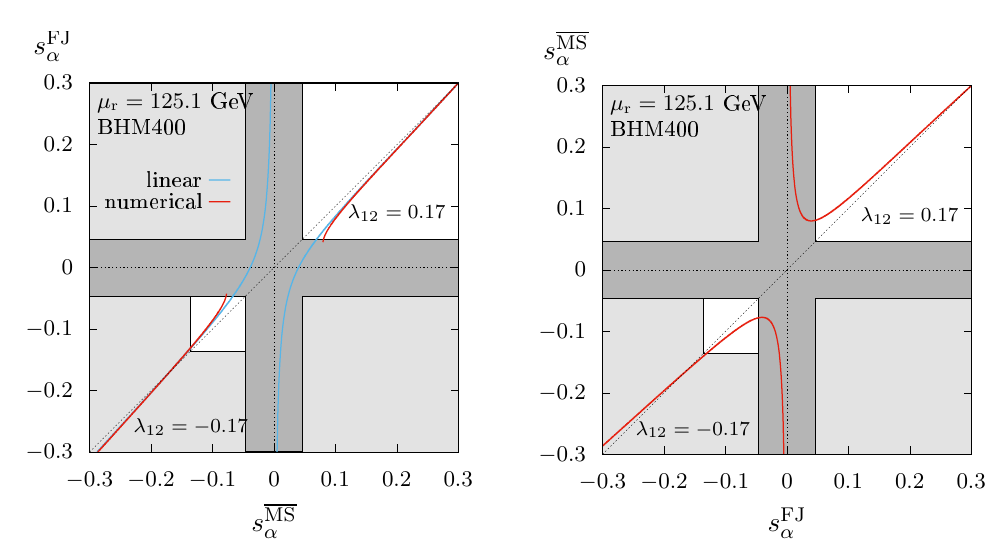
Figure 29 . As in (cid:12)gure 14, but for benchmark scenario BHM200 (cid:0) .